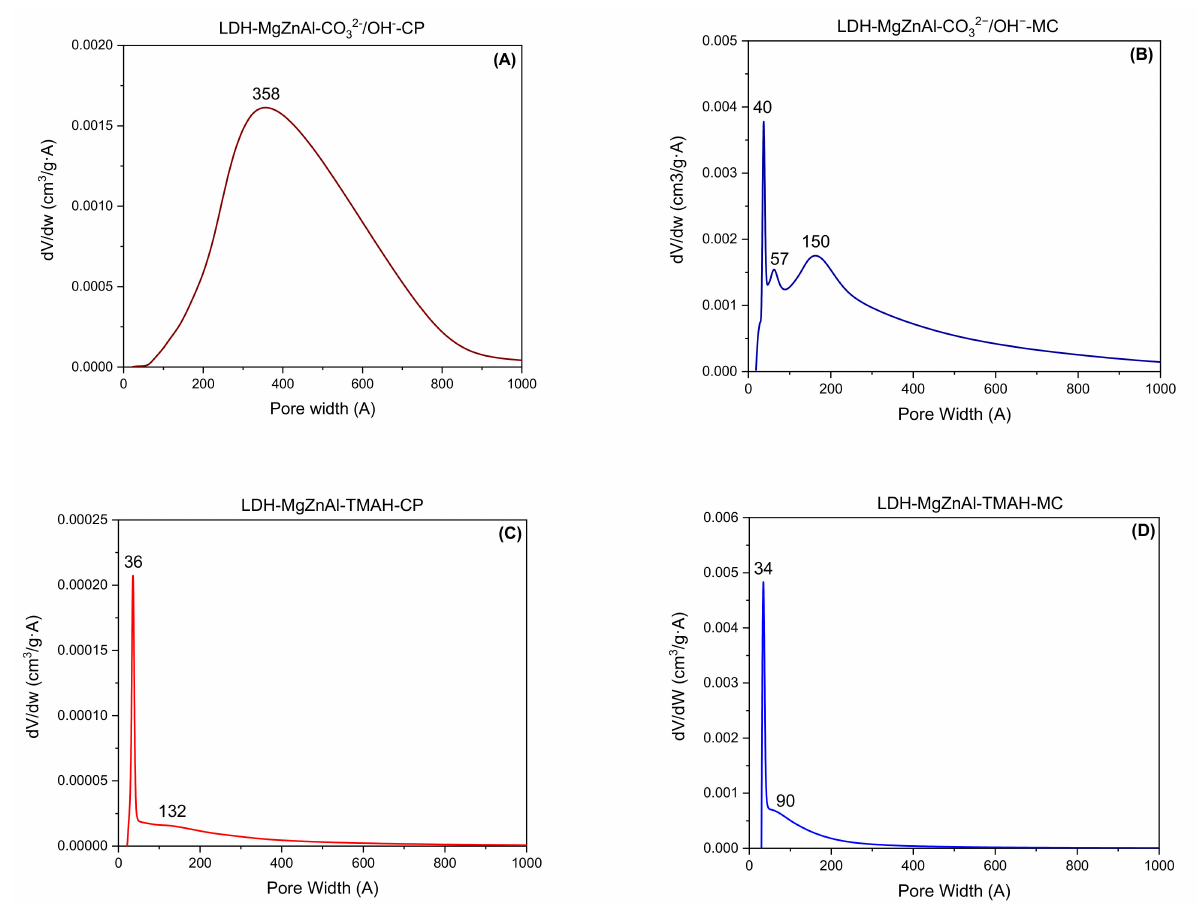
Figure 4. The representation of LDH sample pore widths; ( A ) LDH-MgZnAl-CO 32 − /OH − -CP; ( B ) LDH-MgZnAl-CO 32 − /OH − -MC; ( C ) LDH-MgZnAl-TMAH-CP; ( D )